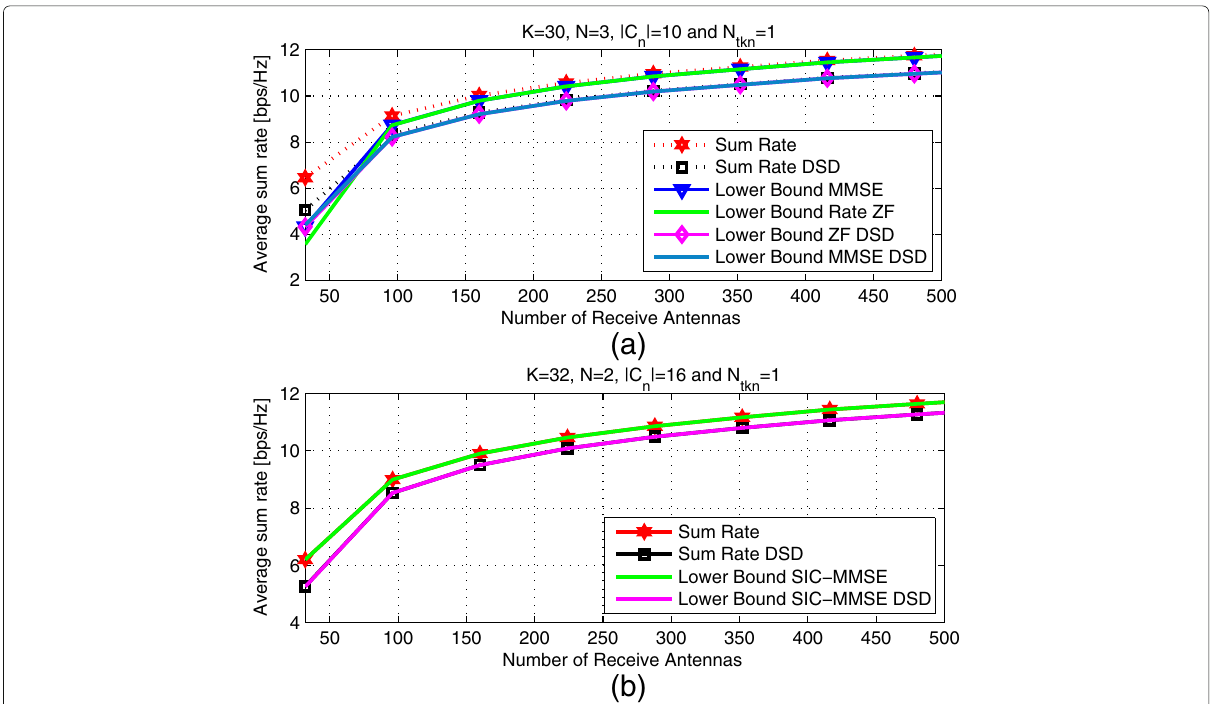
= 1 antenna per user. b Sum rate vs number of receive k , n